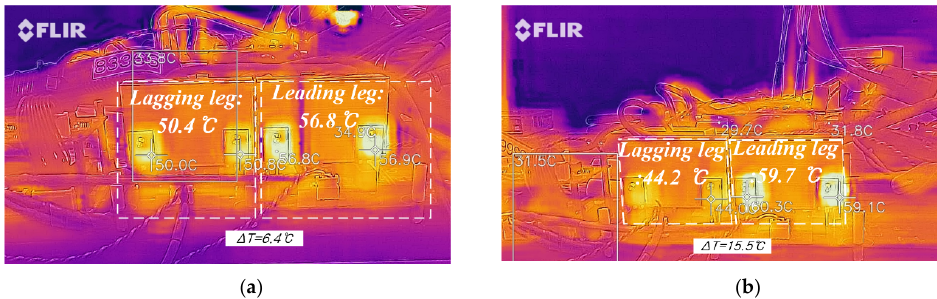
Figure 4. Measurements of temperature imbalances in the power device under the phase-shift full-bridge (PSFB) light-load condition: ( a ) state in which no leg achieved ZVS, ( b ) state in which the lagging leg achieved zero-voltage switching (ZVS).